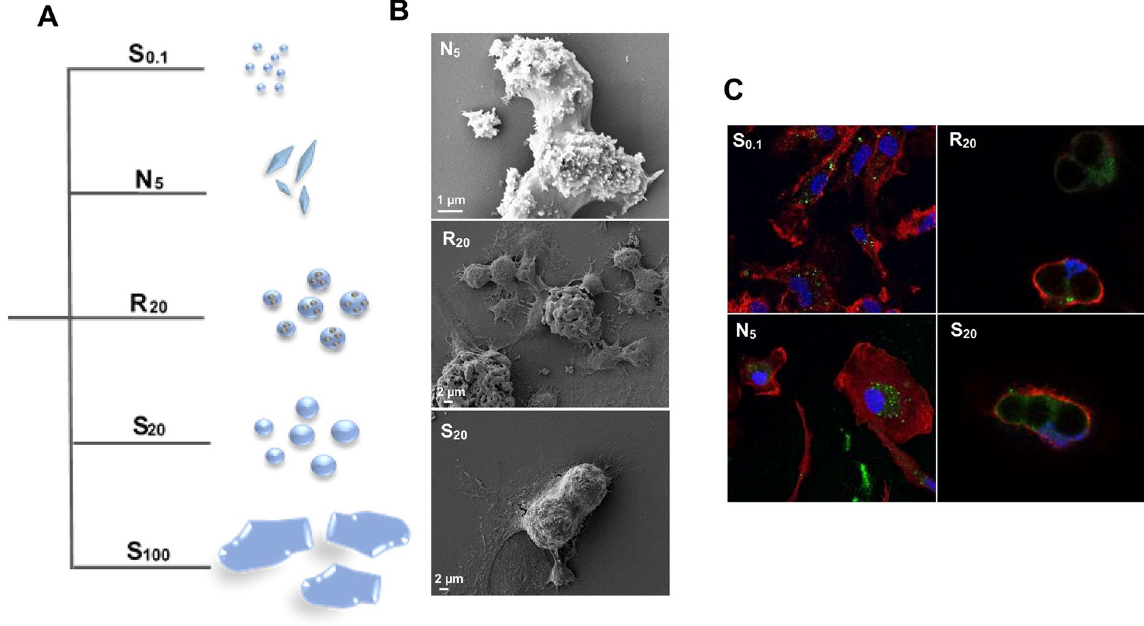
Figure 1. ( A ) Schematic of hydroxyapatite particles. ( B ) HA internalization by BMDCs. SEM images of BMDCs incubated with N 5 , R 20 and S 20 particles for 18 h. ( C ) Confocal fluorescence microscopy images of BMDCs incubated with FITC-labelled (green) S 0.1 , N 5 , R 20 and S 20 for 24 h to visualize the individual internalized particles. Membrane staining with phalloidin–TRITC (red) and nuclear staining with DAPI (blue).